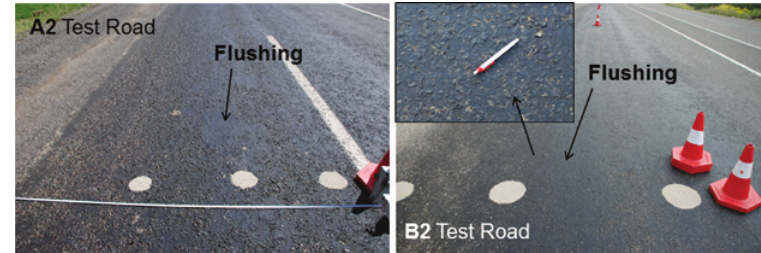
and B test roads. 2 2